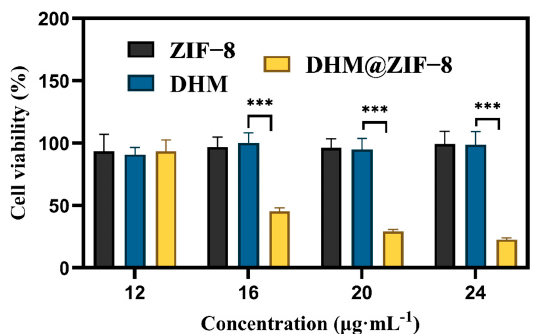
Figure 4. Cell viability of HepG2 cells treated with different concentrations of samples for 12 h. Data are representative of four independent experiments. *** p < 0.001 vs. DHM.